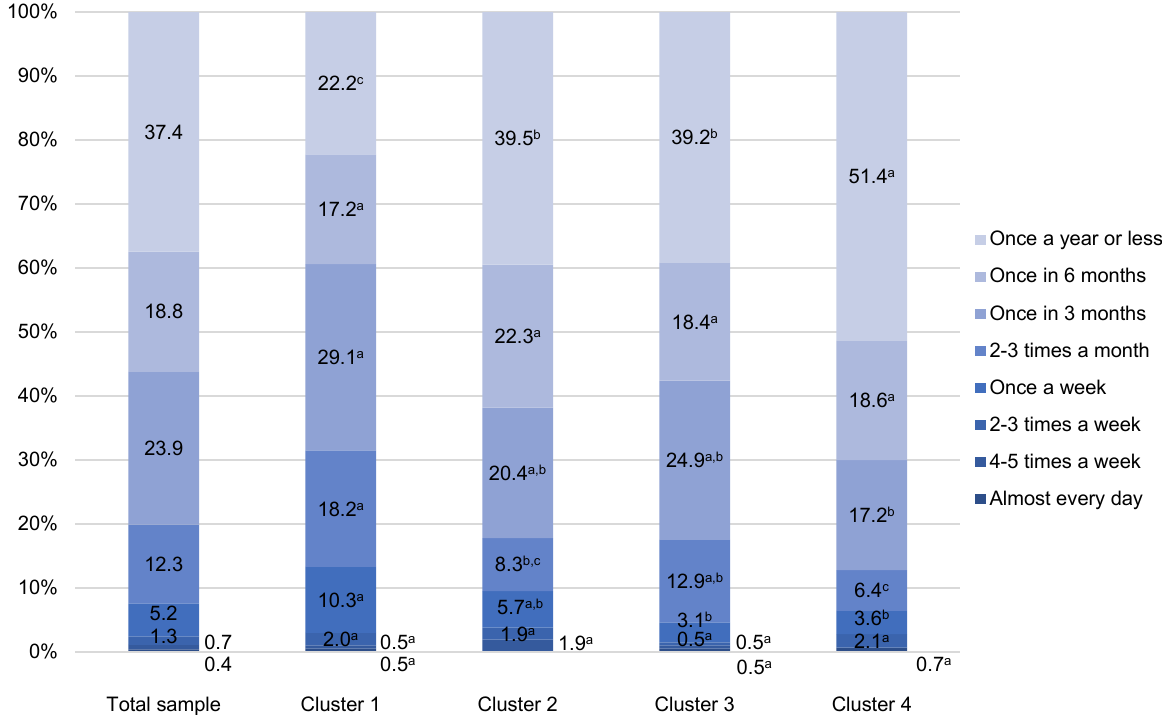
Figure 3. Away-from-home white fish consumption of Croatian fishery consumers (n = 918). a–c Dif- ferent letters in the same consumption frequency category indicate statistically significant differences ( p < 0.001).